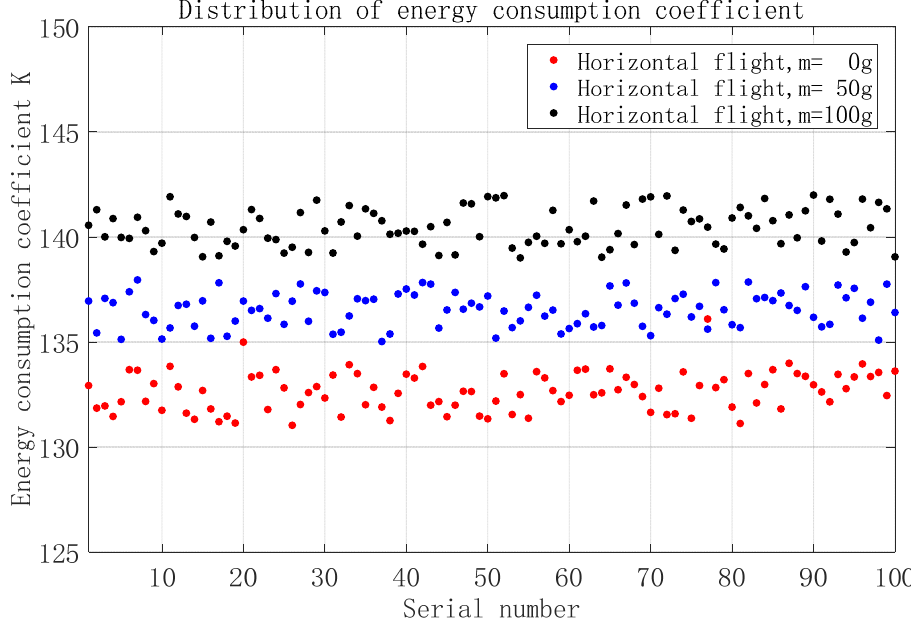
Figure 4. Distribution of flight energy consumption coefficient at different load